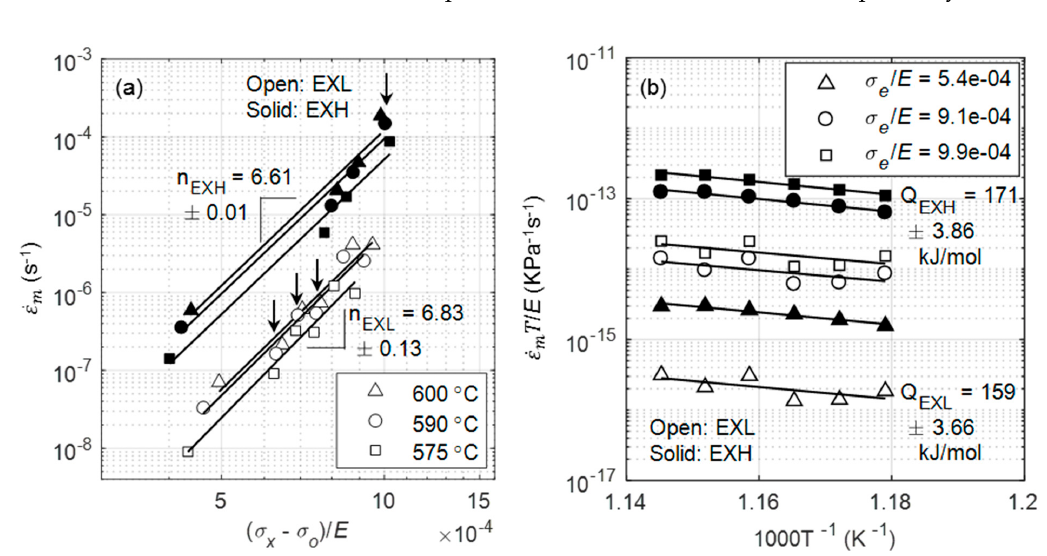
Figure 20. ( a ) Calculation of stress exponents from log-log plot of minimum creep rate versus normalised effective stress with data from square specimens indicated by arrows; ( b ) Calculation of activation energies for EXL (open symbols) and EXH (solid symbols) at three modulus compensated stresses.